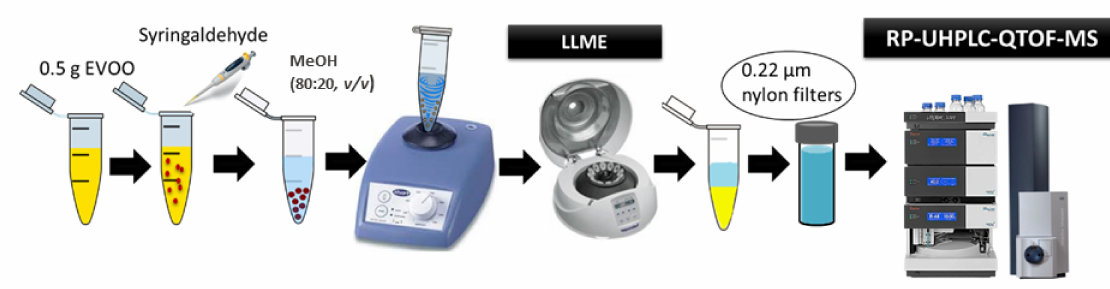
Figure 7. Geographical origin of EVOOs from the two harvesting seasons 2016–2017 and 2017–2018.